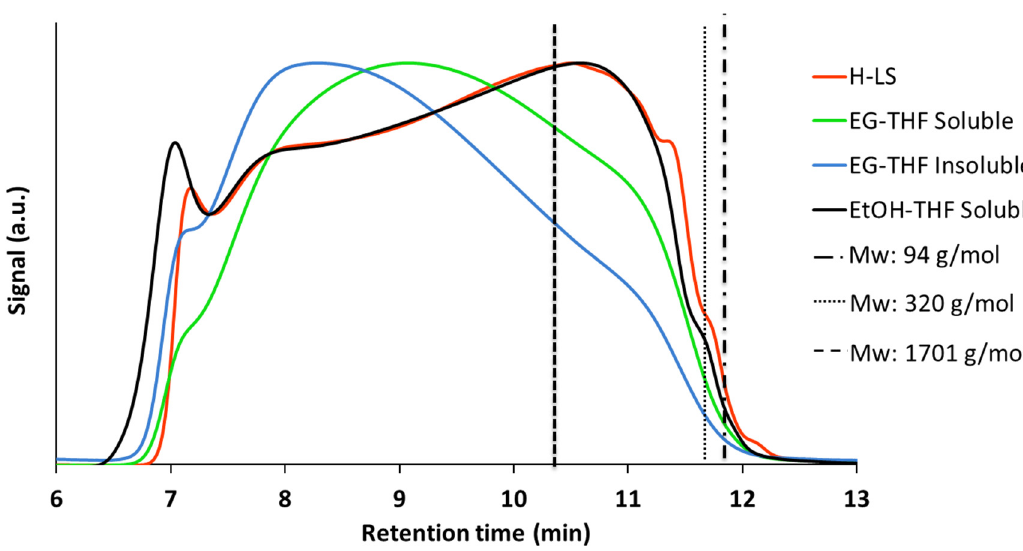
Figure 4. SEC analysis of the solid phases from catalytic conversion of H-LS in EtOH and EG media. Reaction condition: 0.75 g Ni/SiO 2 catalyst, 7.5 g H-LS, 75 mL solvent, initial H 2 loading of 50 bar at RT, reaction temperature of 250 °C, 3 h reaction time.